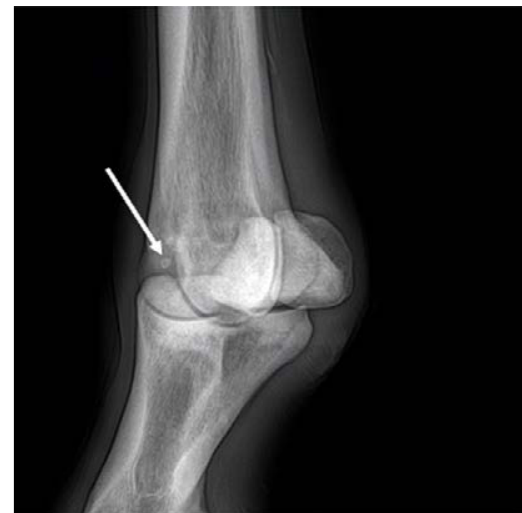
Figure 5: Dorsolateral-palmaromedial projection of the fetlock of a 12-year-old Arab stallion. Note the articular fragment at the dorsoproximal aspect of the proximal phalanx.